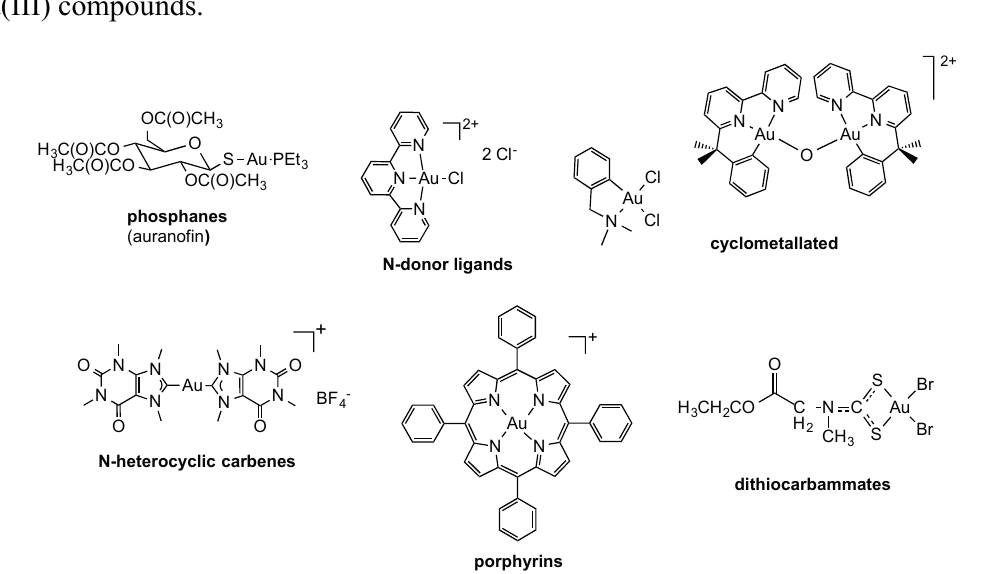
Figure 4. Examples of cytotoxic coordination and organometallic gold(I) and gold(III)